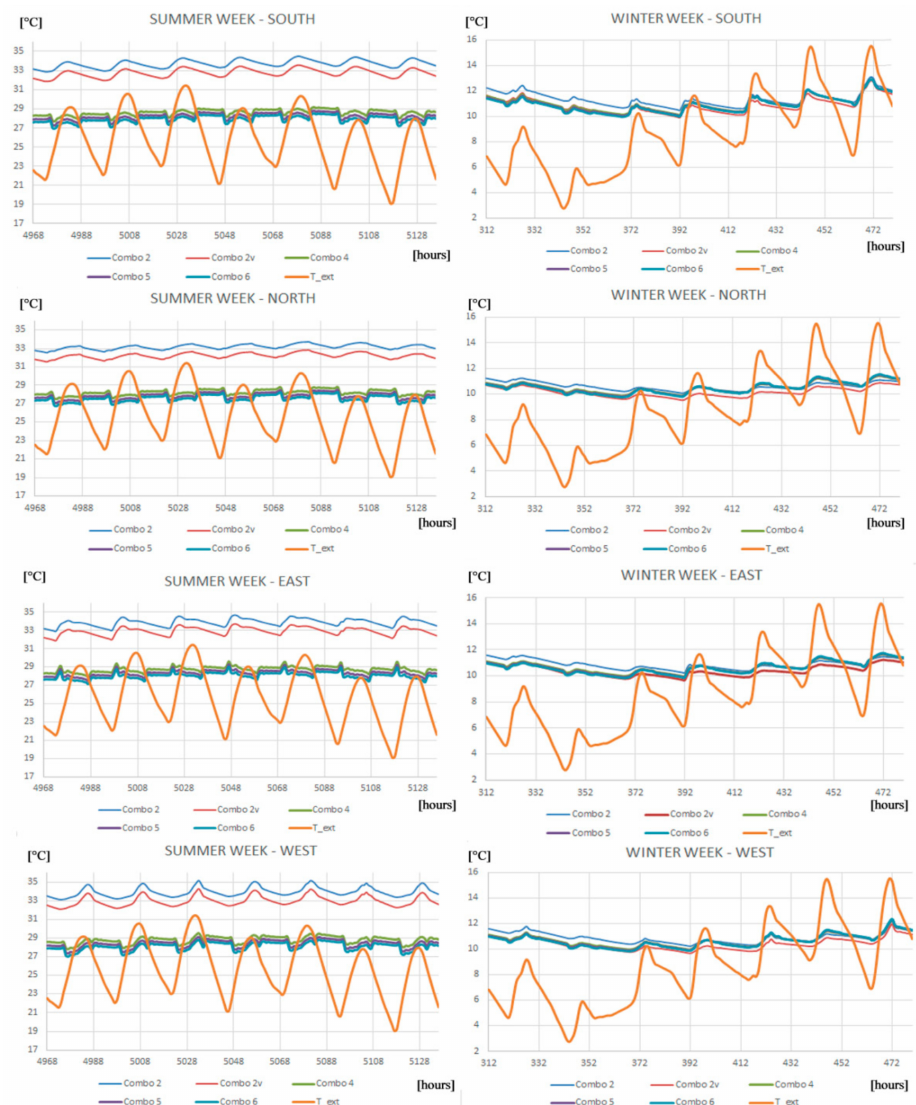
Figure 6. TOP trend for Combos 2, 2v, 4, 5, and 6, and the external air temperature (27 July–2 August; 14 January–20